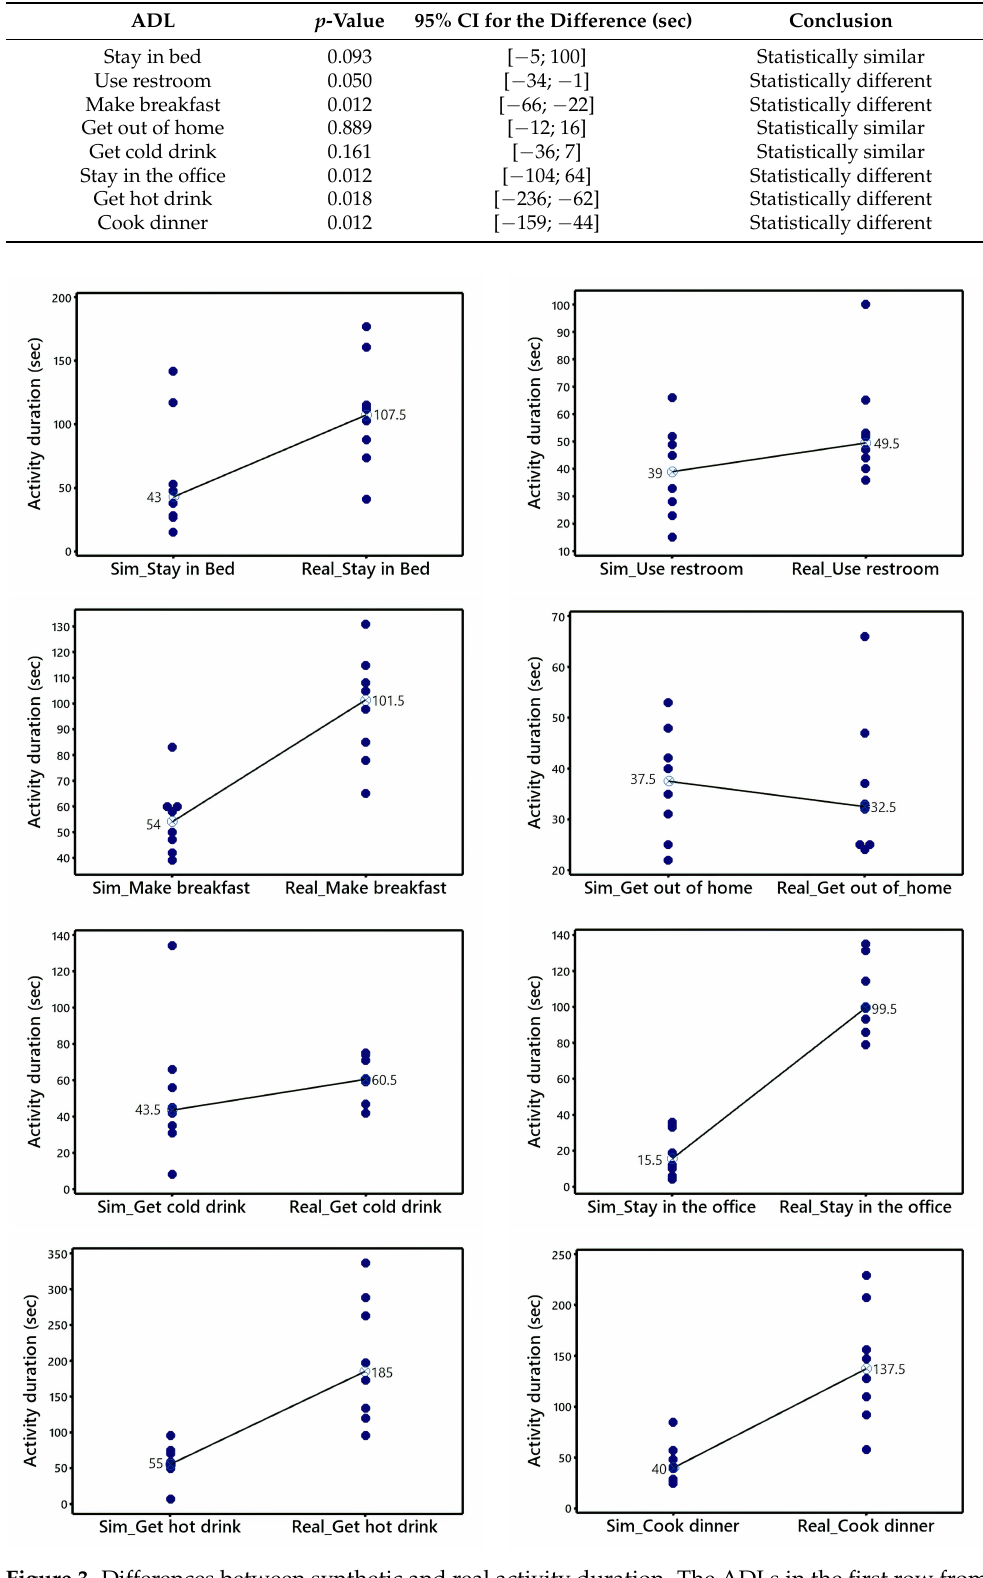
Table 1. Two-sample Wilcoxon test results.